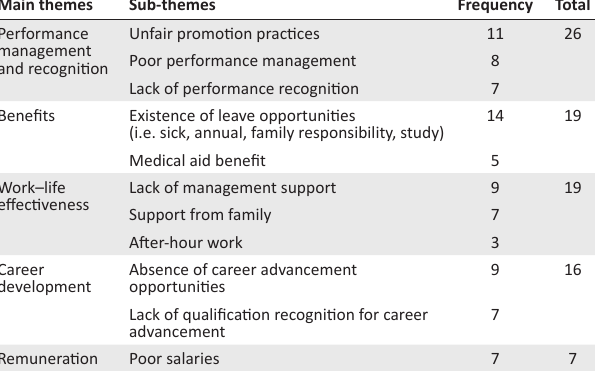
TABLE 3: Main themes and